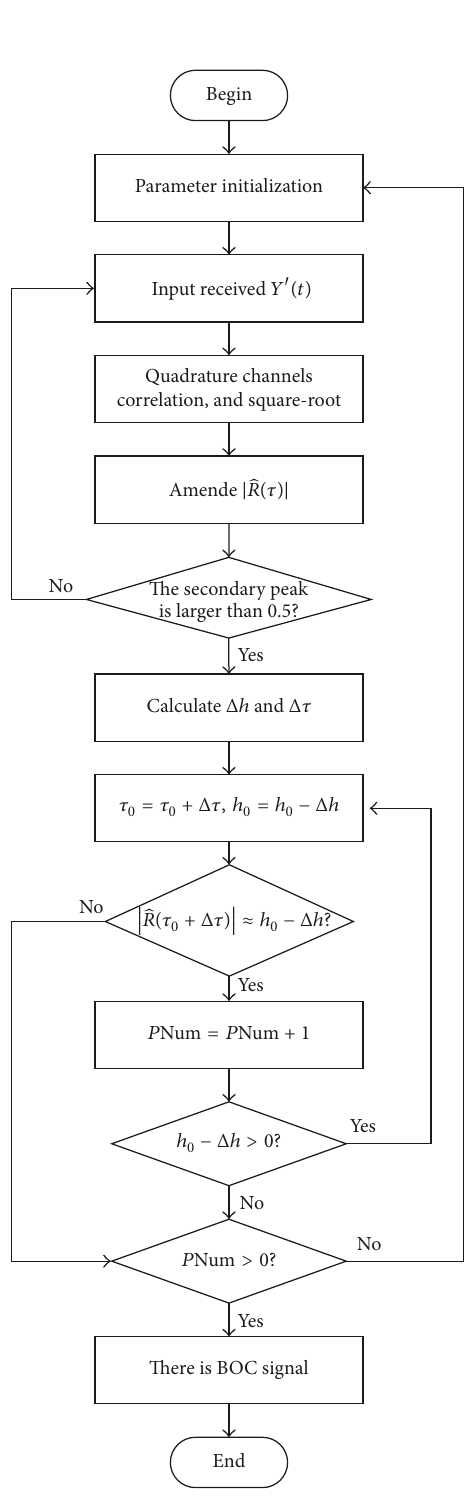
Figure 6: Flowchart of the proposed